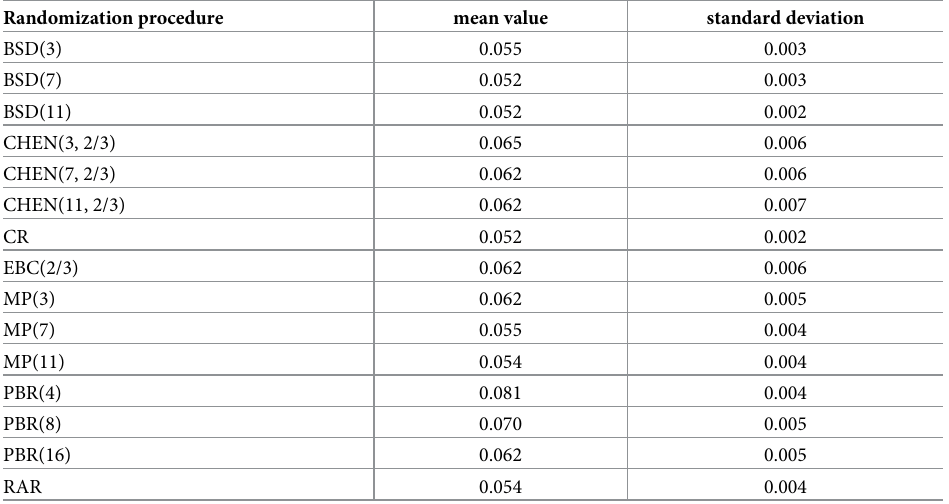
Table 3. Summary statistics of type I error probabilities by randomization